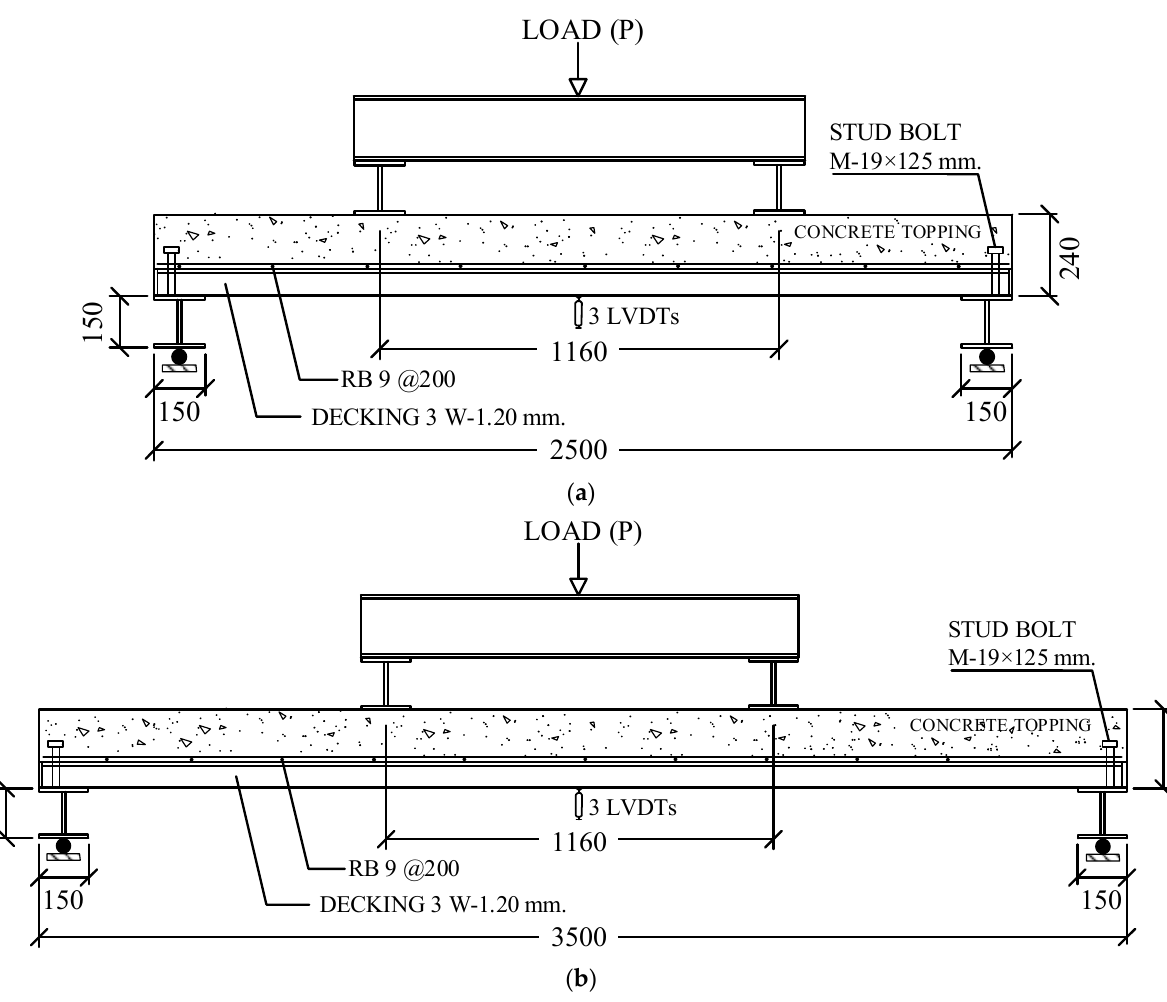
Figure 3. Test setup of composite deck. ( a ) Specimens S1 and S2 (dimensions in mm). ( b ) Specimens S3 and S4 (dimensions in mm).